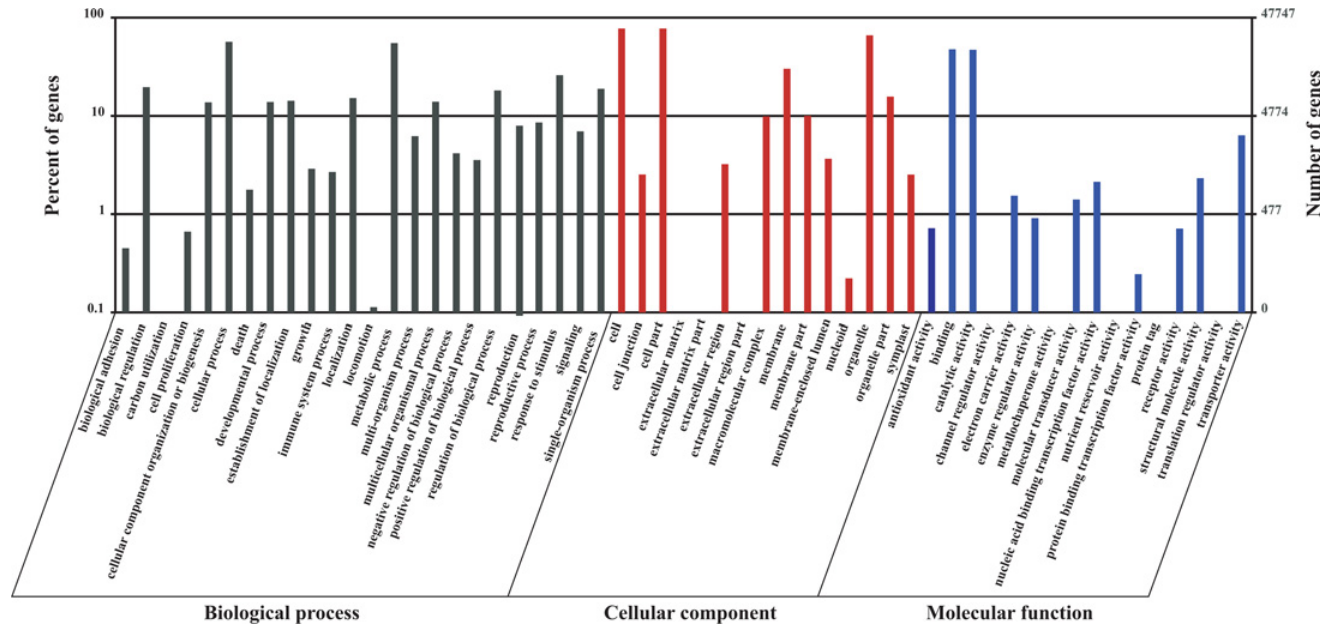
Fig 3. Histogram of the GO (gene ontology) classification of the S . grandis unigenes. All 47,747 unigenes were grouped into three ontologies: molecular function, cellular component and biological process. The y-axis indicates the percentage (left) and number (right) of genes in each term.